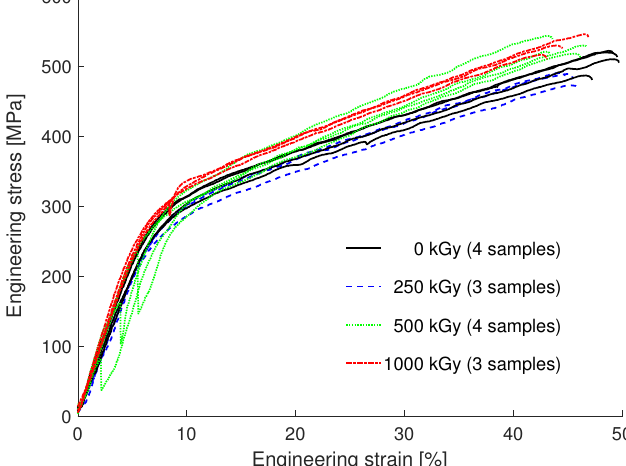
Figure 7. Results of the tensile experiments of the Upilex-S VDA foils exposed to irradiation doses of 0kGy, 250kGy, 500kGy and 1000kGy. The number of tested samples for each irradiation dose is indicated. There is no significant influence of the irradiation dose up to 1000 kGy. The deviation from a straight line in the linear elastic part shown by three curves, stems from a small rotation of the sample head due to a non-proper alignment with the gripper at the beginning of the tensile